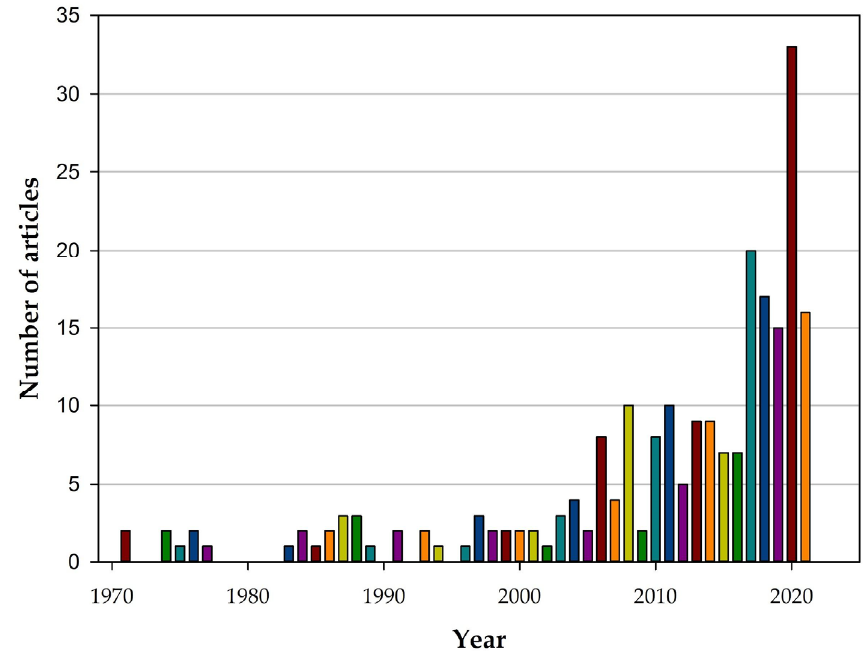
Figure 3. Annual production of scientific publications included in the systematic review.